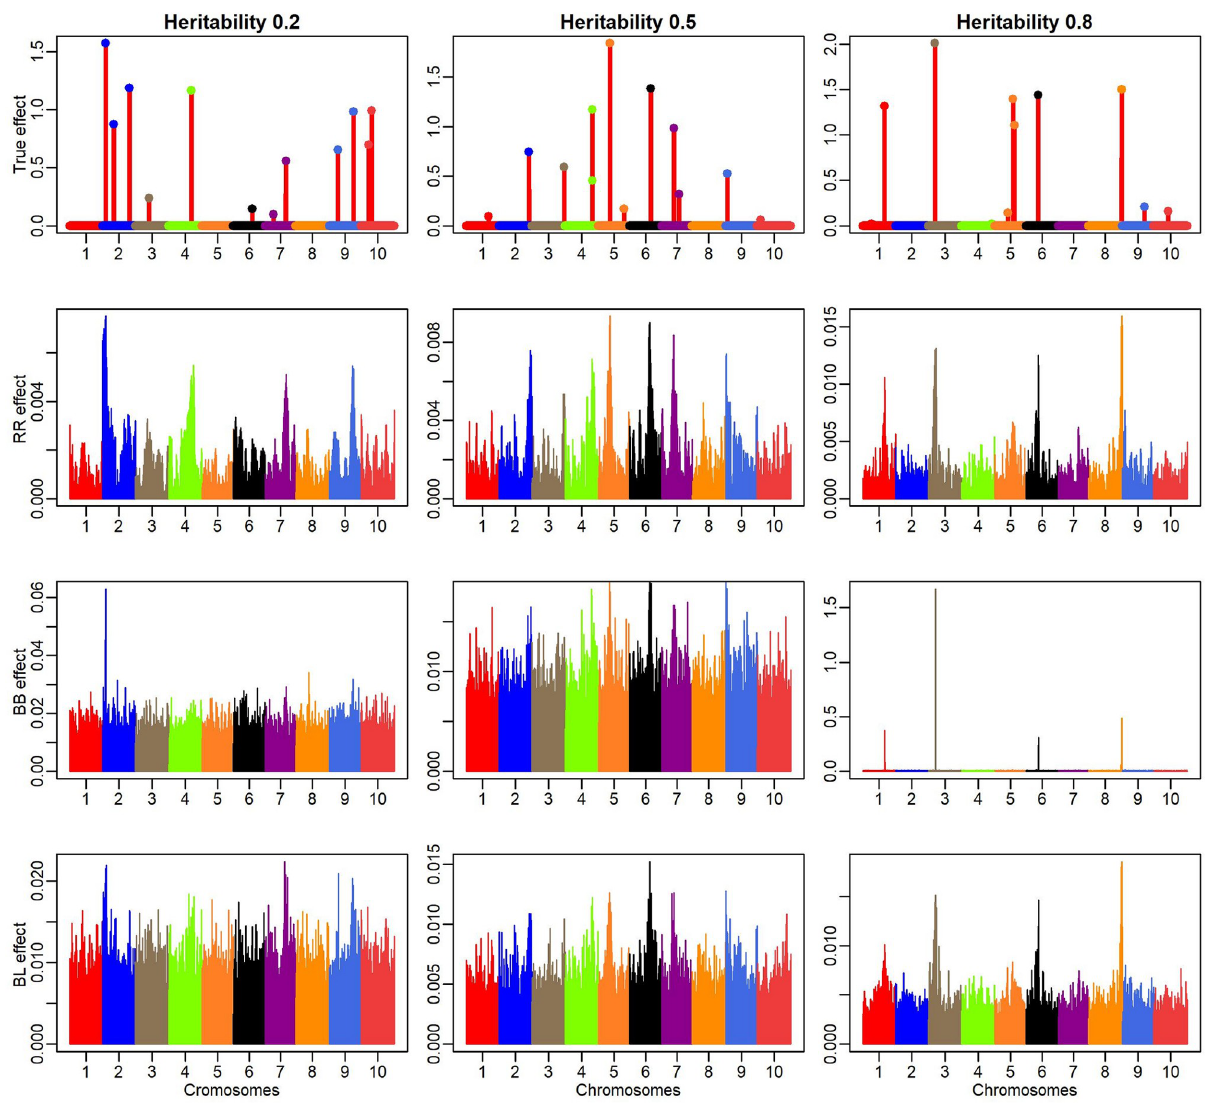
Fig 2. Absolute simulated actual effects of QTL along the genome and absolute estimates from methods rr-BLUP (RR), Bayes B (BB) and Bayesian Lasso (BL). Colored dots represent the 12 true QTL, which are distributed across 12,150 SNP over 10 linkage groups. There is a scale